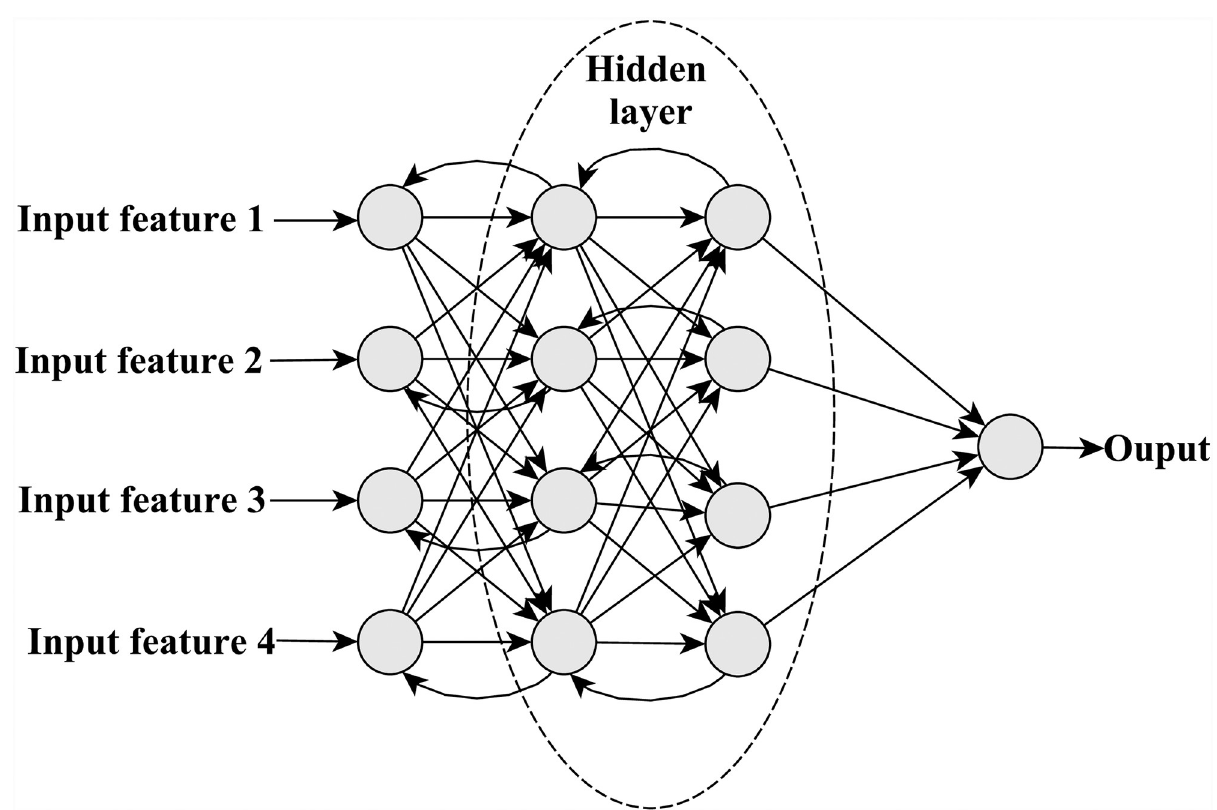
Fig 3. Neural network